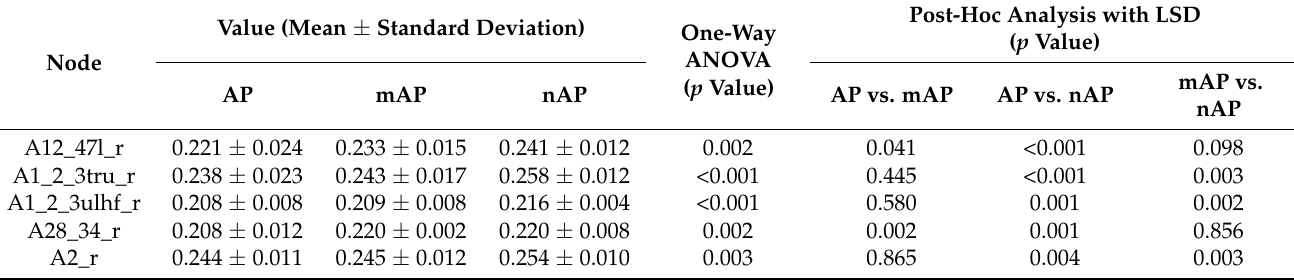
Table 3. Significant alterations of nodal